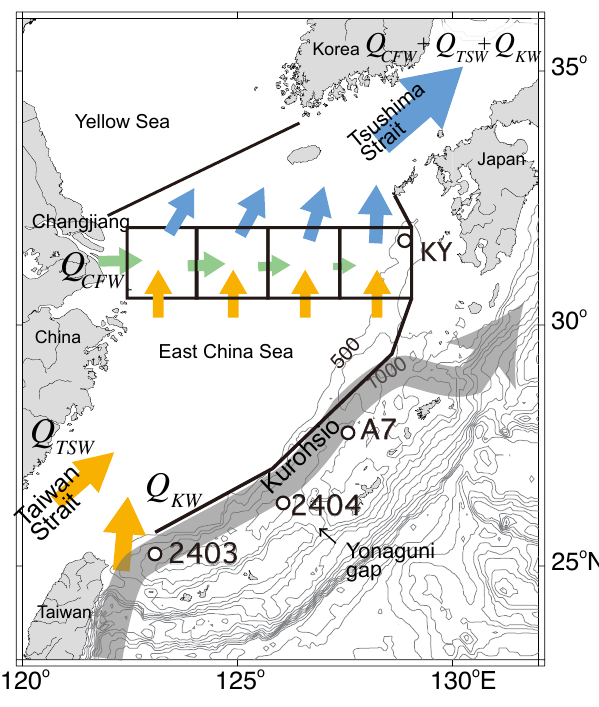
Figure 3. A map showing the simplified modern current system during summer in the East China Sea (ECS). Water fluxes into the ECS shelf are described as Q KW ,Q TSW , and Q CFW . Sub- scripts KW, TSW, and CFW represent Kuroshio Waters, Taiwan Strait Water, and Changjiang freshwater, respectively. Orange ar- rows represent fluxes of the Kuroshio Waters and Taiwan Strait Water onto the shelf. Green arrows represent fluxes of Changjiang freshwater of each box. Blue arrows represent fluxes of seawater mixed with the Changjiang freshwater. The gray arrow represents the Kuroshio Current in the Okinawa Trough. Net water exchange between the Yellow and East China seas is not taken into account. The Kuroshio Waters are considered to be intruding to the shelf area mainly through northeastern Taiwan (Chen et al., 1995). Core sites of KY07-04-01 (this study), A7 (Sun et al., 2005), 2404 (Chen et al., 2010), and 2403 (Lin et al., 2006) are denoted as open